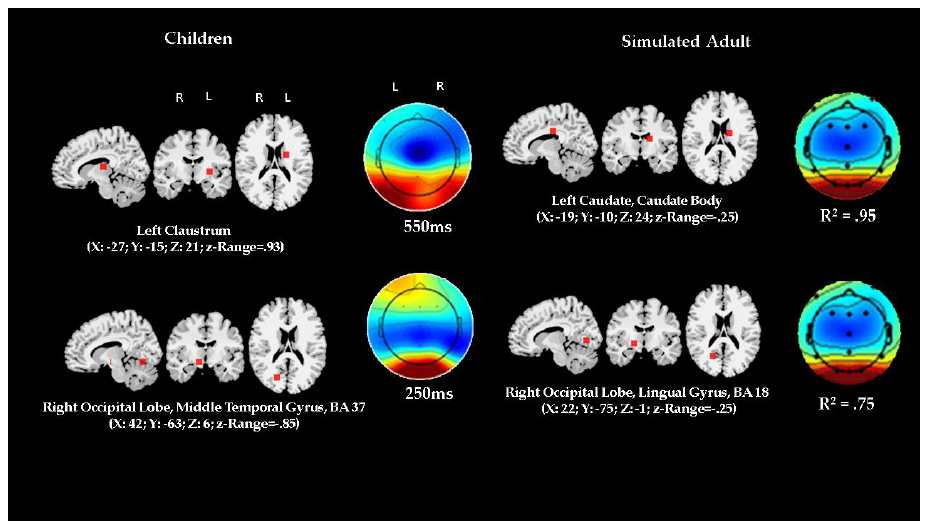
Figure 8. Comparison between dipole source analysis and topographical mappings of actual preschool children ERP data and simulated ERP data by using an ACT–R modeling architecture in the distractor condition. Timings are set by the ACT–R model module production schedule simulation (given in Figure 3). Coefficient of determinations show fit results for actual and simulated topographic maps comparisons. “R” represents right, and “L” represents left (Please note that lateral side of brain is showed opposite to perspective of the observer in MRI scans). Z -range represents range of normalized Talairach coordinates and is a measure of margin of error expressed as z score; comparisons between the z-ranges in actual and simulated data showed no significant differences. The z -scores of the variation in matched anatomical localizations did not show significant differences between the children’s and the adult simulated data. Similarly, there was a strong fit between the topographic maps of the actual observed children’s data and the simulated adult data.